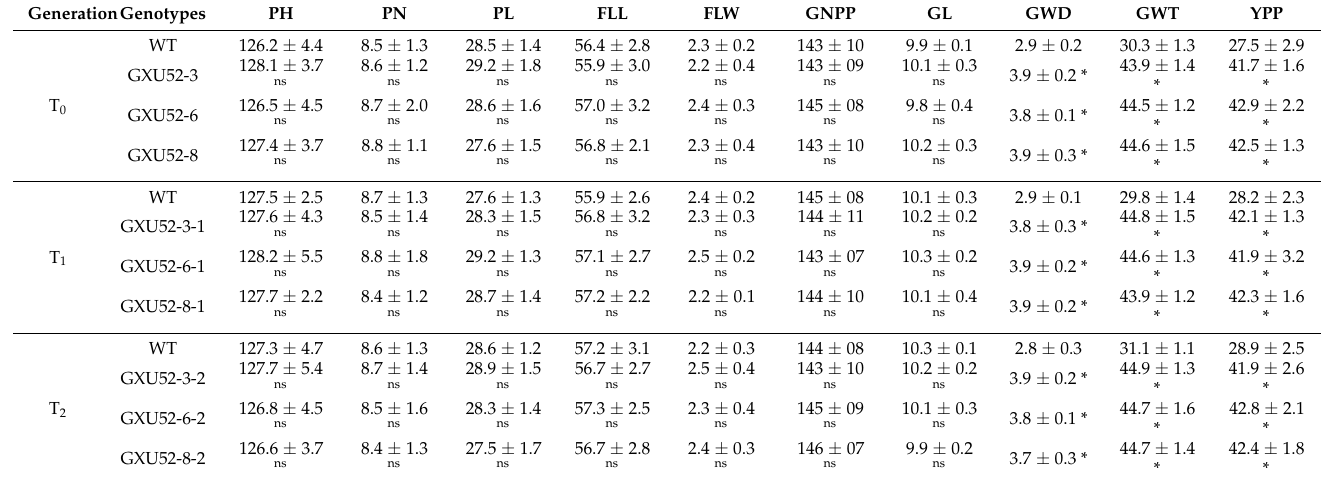
Table 1. Increased yield of mutant lines in T 0 , T 1 , and T 2 generations.